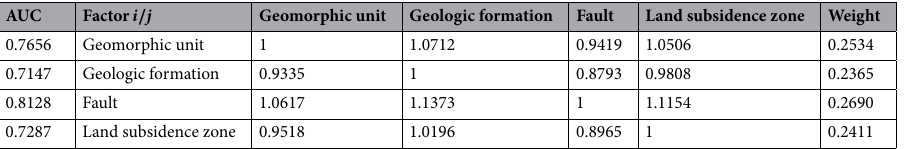
Table 6. Reciprocal pairwise comparison matrix of the